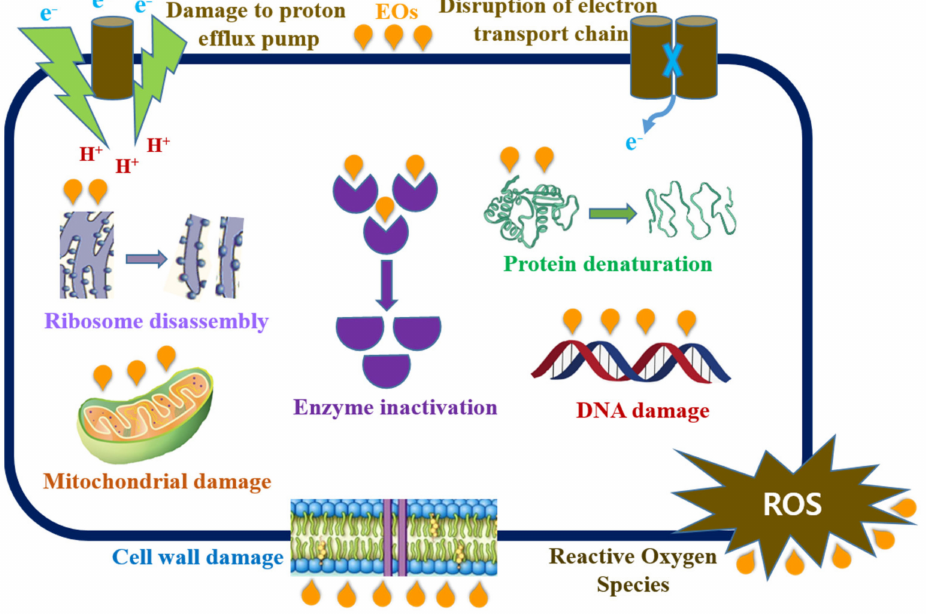
Figure 3. Proposed mechanism of antibacterial action of essential